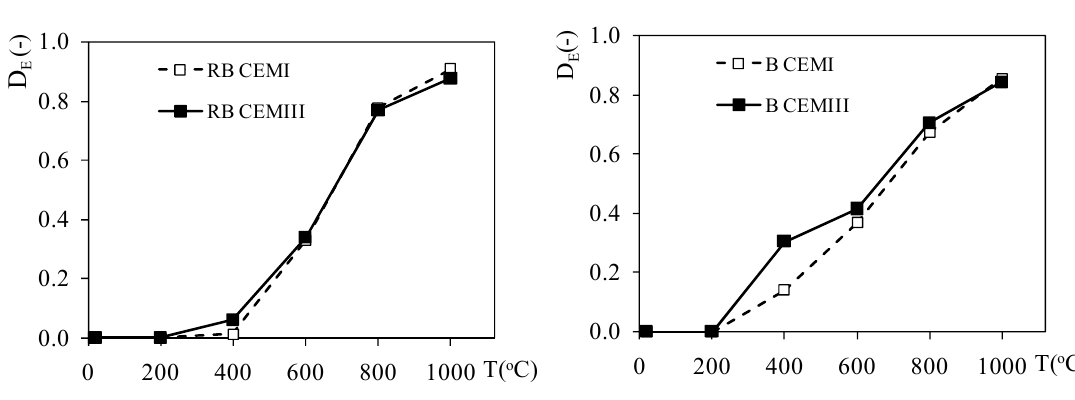
Figure 8. Damage factor ( D E ) as a function of temperature.